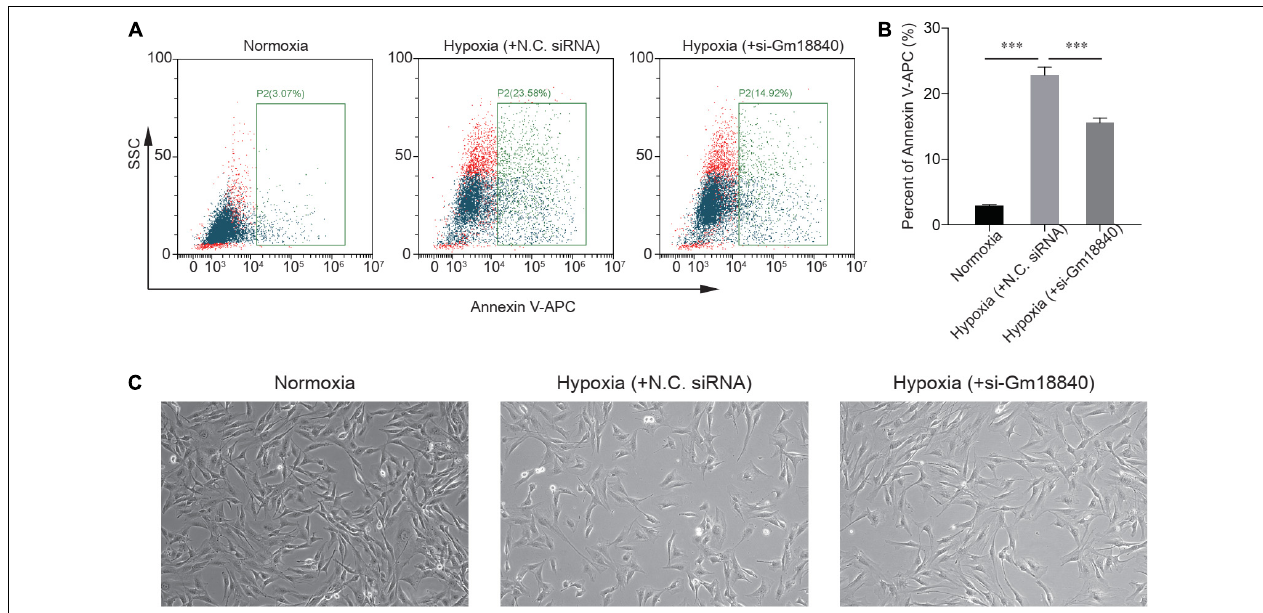
FIGURE 3 | Knockdown of Gm18840 reduced hypoxia-induced apoptosis in cardiac muscle cells. (A,B) Knockdown of Gm18840 decreased hypoxia-resultant apoptosis in HL-1 cells. Representative flow cytometry (A) and statistical analysis (B) are shown. HL-1 cells were treated with siRNA targeting Gm18840 before hypoxia experiments. For the hypoxia experiments, HL-1 cells were cultured in 20% oxygen (normoxia) or 1% oxygen (hypoxia) for 24 h. The cells were harvested 24 h after exposure to hypoxia or normoxia culture. (C) Morphology of HL-1 cells under normoxia, hypoxia with negative control (NC) siRNA, or hypoxia with siRNA targeting Gm18840. *** p <